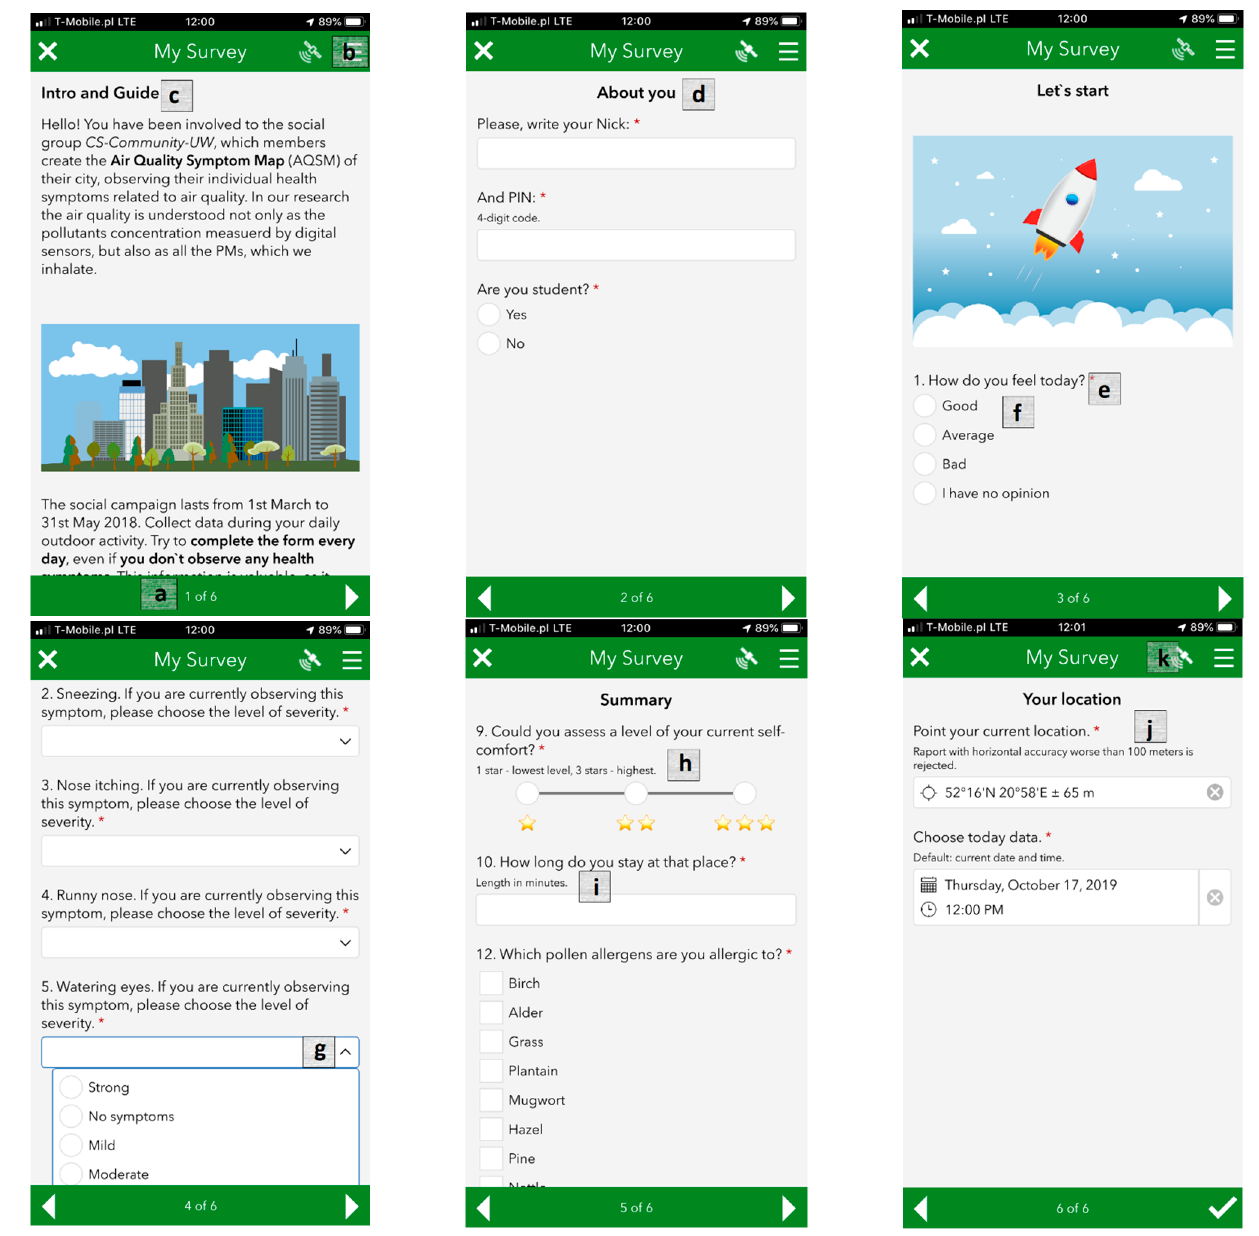
Figure A1. Six-page mobile survey app user interface: ( a ) six-page navigation, ( b ) button to choose a language, ( c ) introduction and user guide, ( d ) user’s basic information, ( e ) obligatory question mark, ( f ) general well-being question, ( g ) health symptom questions, ( h ) repeated well-being question, ( i ) length present in the place report, ( j ) location and date, and ( k ) current location status.